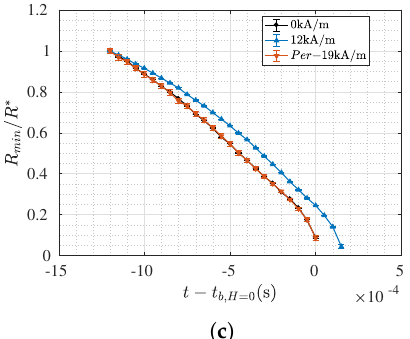
Figure 7. Time evolution of the normalised minimum radius ( R / R ∗ ) under the application of an external magnetic field with different intensities and different orientations. Each plot corresponds to each water-based ferrofluid, where Per referes to the perpendicular configuration and only the curves corresponding to the highest intensity fields are shown for the sake of clarity. ( a ) EMG-308, ( b ) EMG-508, ( c )